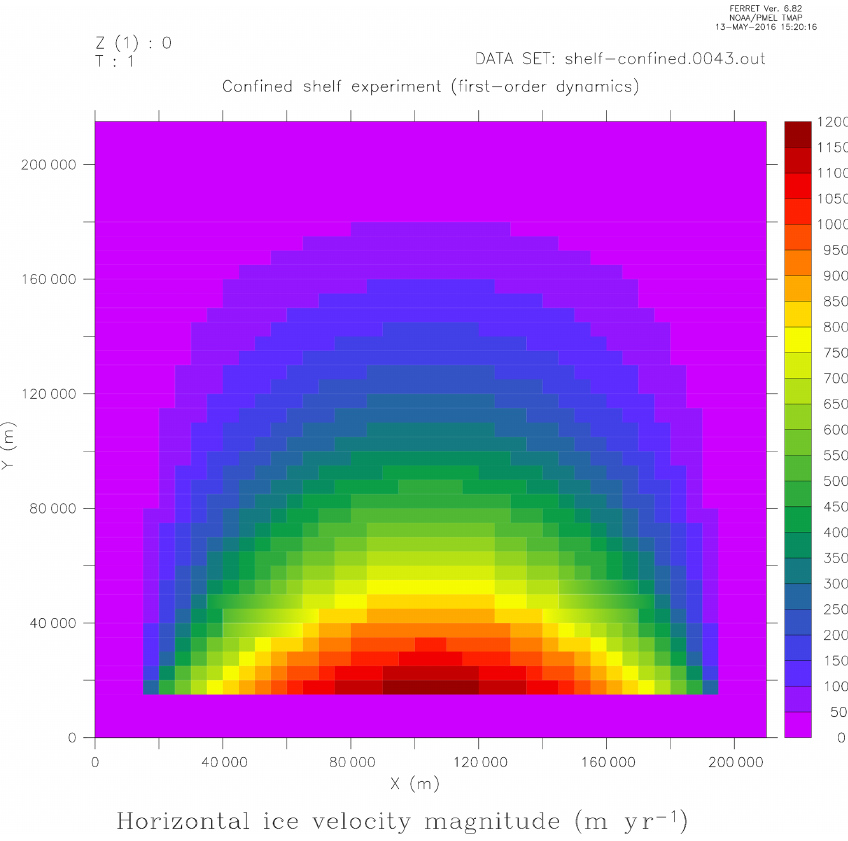
Figure 8. Ice speed (myr − 1 ) for the confined-shelf test (based on tests 3 and 4 from the Ice Shelf Model Intercomparison exercise of Rommelaere, 1996) using Glissade’s SSA velocity solver. The ice shelf is 500m thick. The rectangular domain is open to the south and confined on the other three sides.